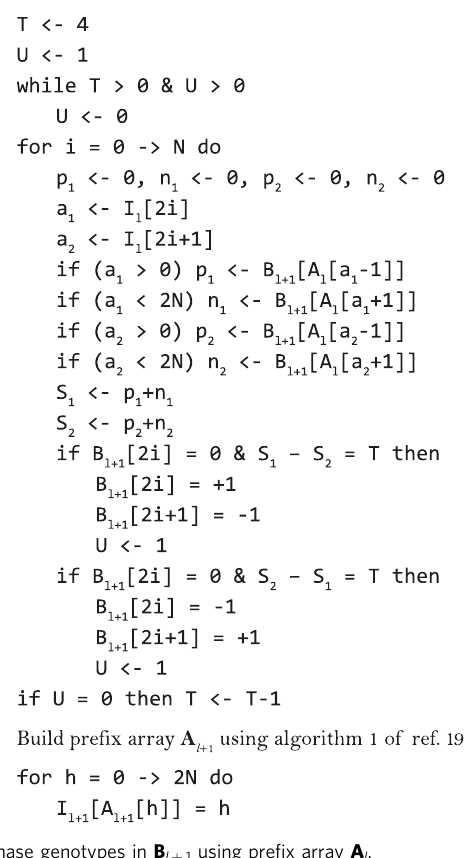
Fig. 5 Phase genotypes in B l + 1 using pre fi x array A l